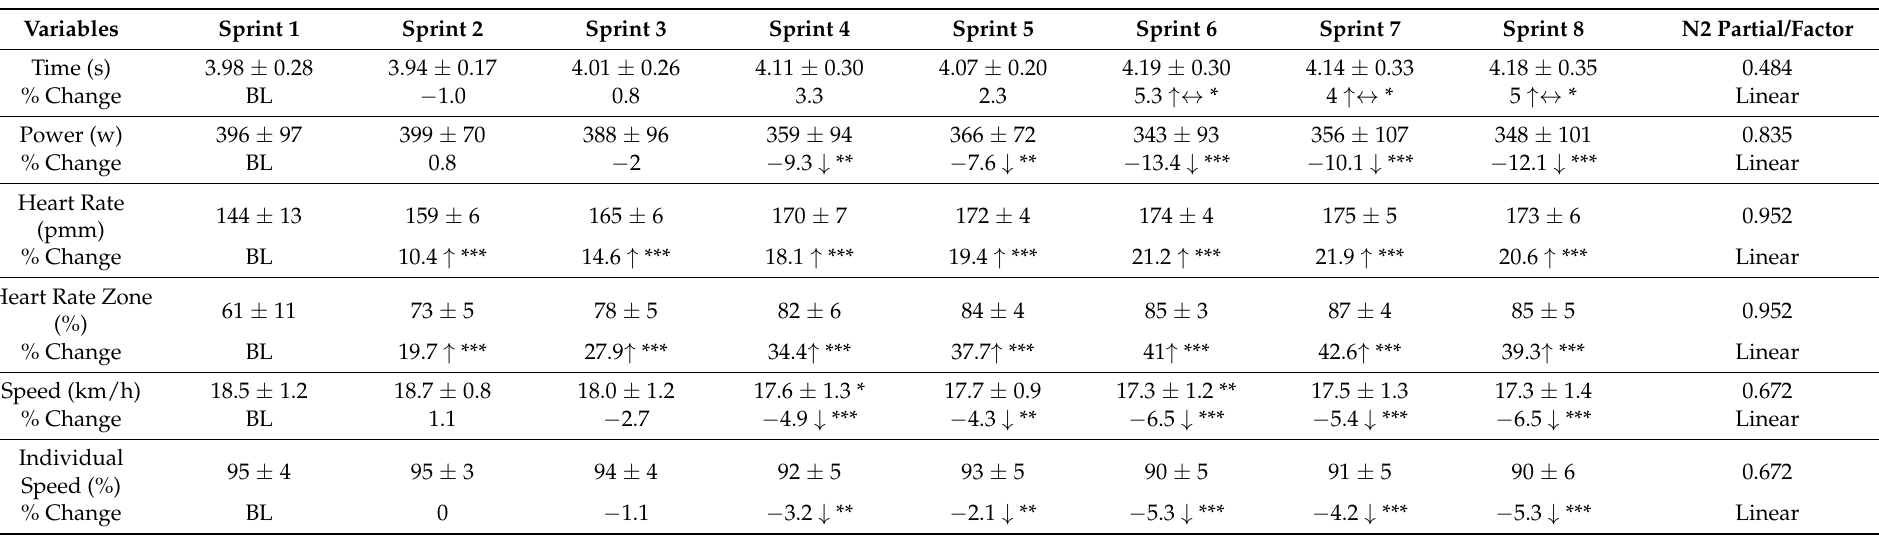
Table 1. Analysis of repeated sprint ability, 20 m, power, heart rate, and speed in women soccer